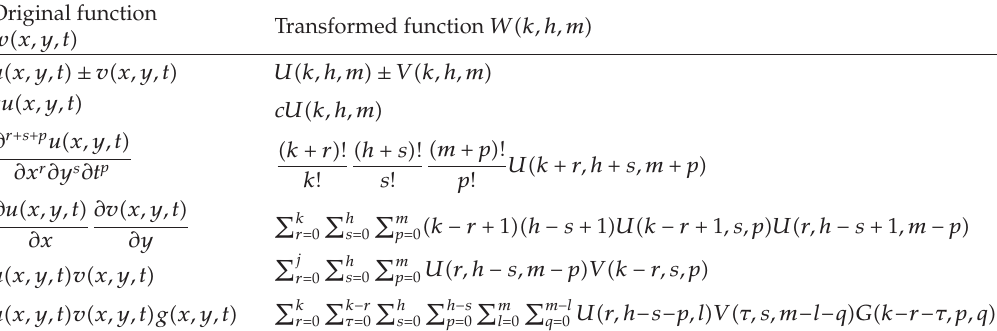
Table 1: Fundamental operations for the three-dimensional